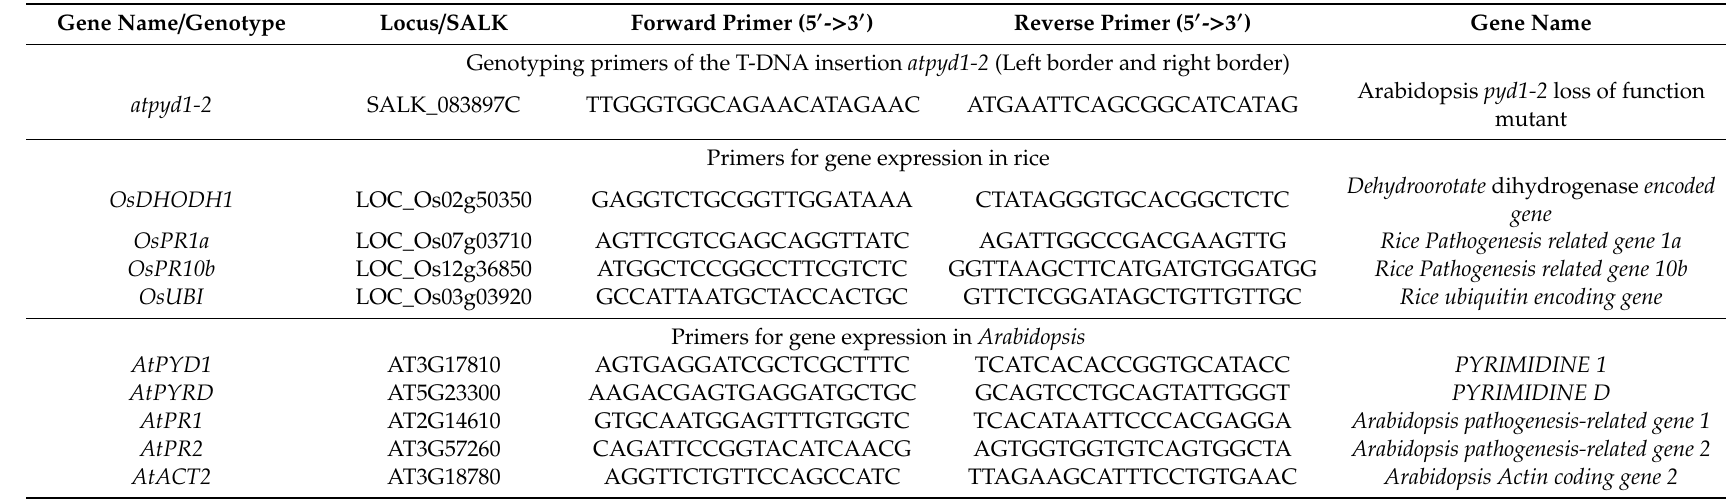
Table 3. List of primers for genotyping and expression of target genes used in the